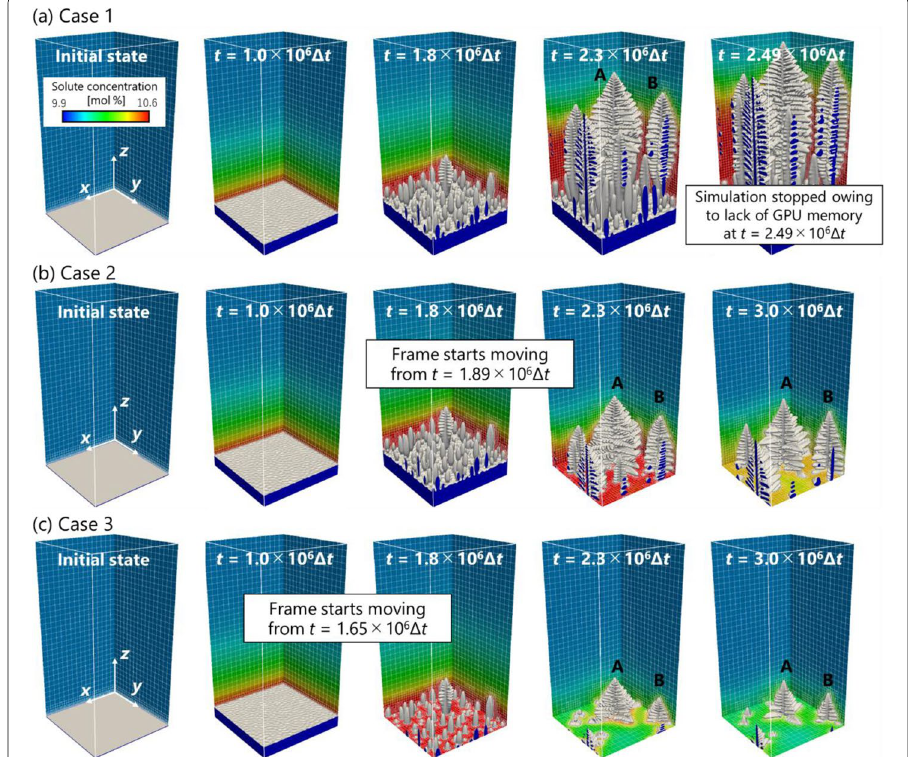
Fig. 5 Time evolutions of dendrite morphologies and solute concentration distributions during the simulations of the directional solidification from a planar solid seed, using parallel computation with 16 GPUs. In the simulations, a a static domain (Case 1) and domains that move in the z-direction to maintain the dendrite tip position at the z-direction positions b h z were used. The dendrite morphologies are indicated by the contours of φ concentration and AMR block decompositions on the xy , yz , and zx planes are indicated by the colored contours and white